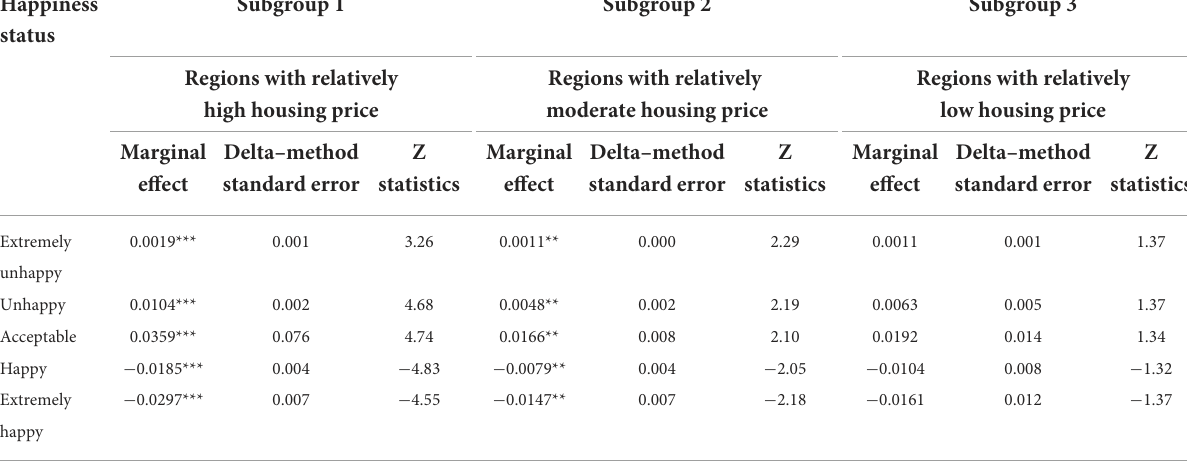
TABLE 11 Marginal effect of higher education on happiness status across various